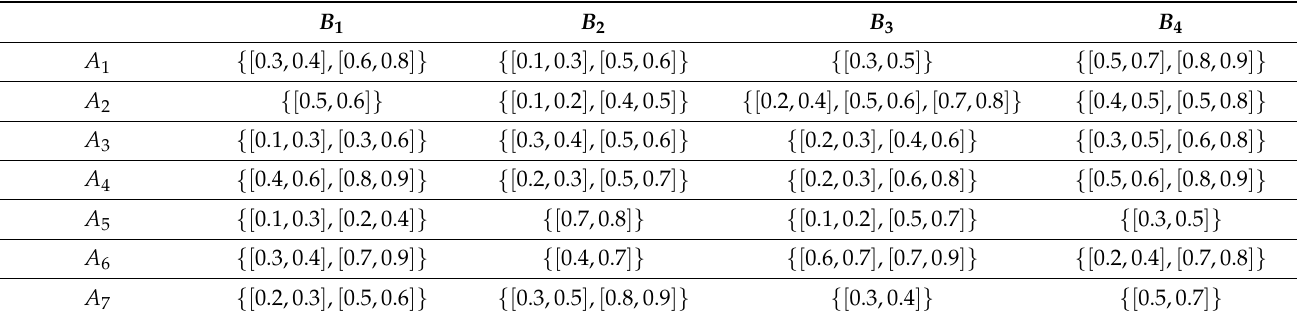
Table 2. Interval-valued hesitant fuzzy preference matrix 1.